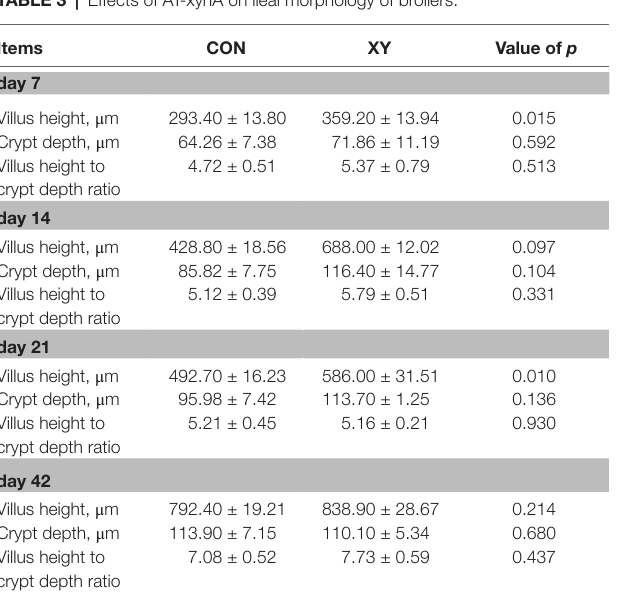
TABLE 3 | Effects of AT-xynA on ileal morphology of broilers.